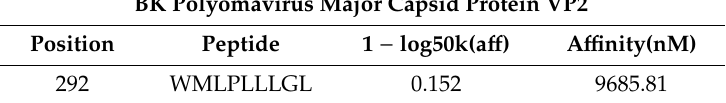
Table 4. High a ffi nity peptide sequences derived from BKPyV major capsid protein VP2 that may be presented by the HLA-E*01:01 allelic variant as identified by the machine-learning bioinformatics algorithm NetMHC 4.0. Position: residue number (starting from 0); peptide: amino acid sequence of the potential ligand.